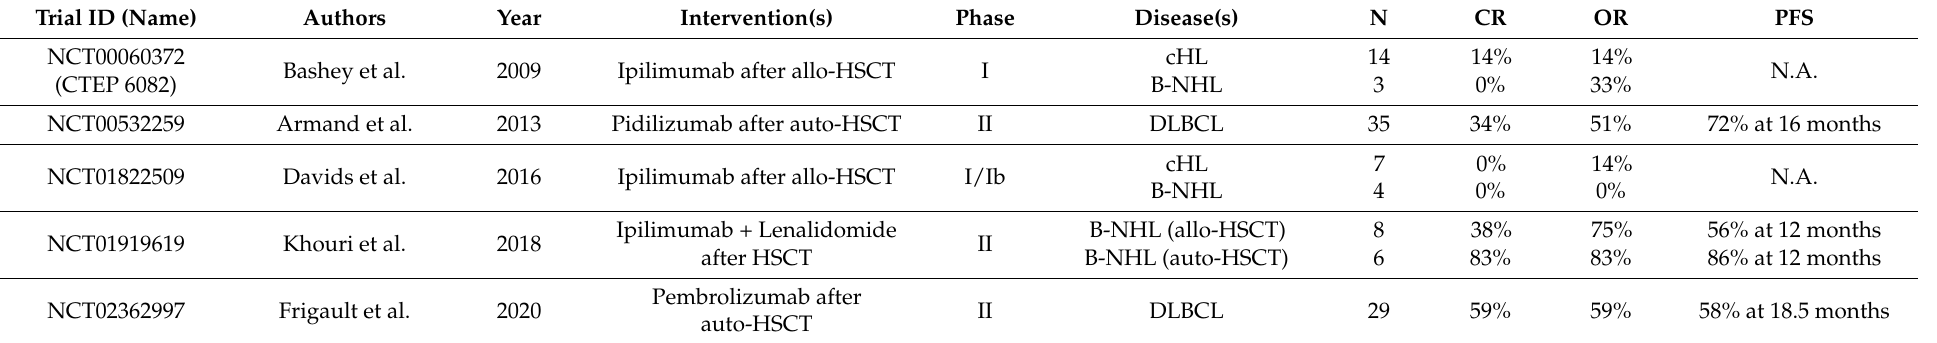
Table 4. Clinical trials of immune checkpoint inhibitors after autologous hematopoietic stem cell transplantation (HSCT).